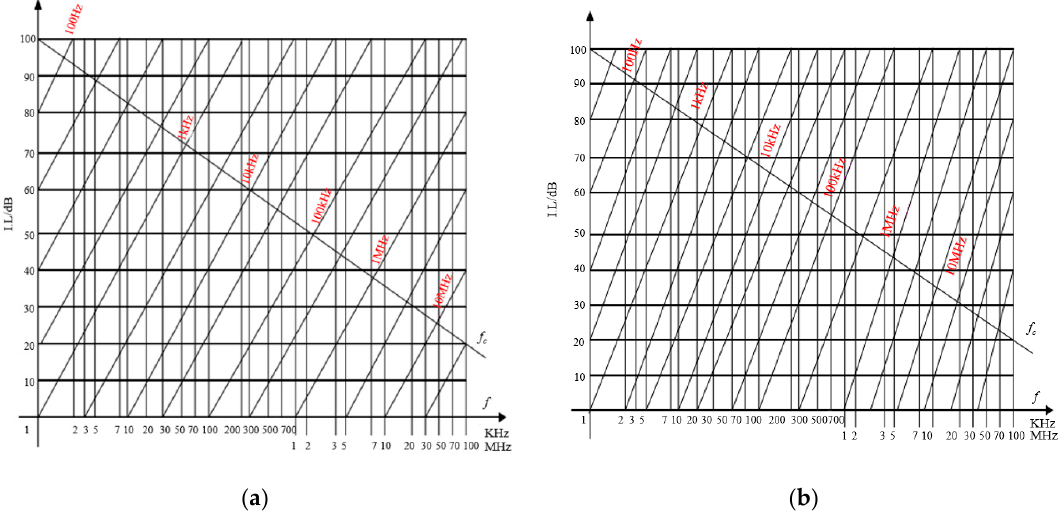
Figure 19. Asymptote of insertion loss curve: ( a ) LC-type filter circuit; ( b ) π -type filter circuit.